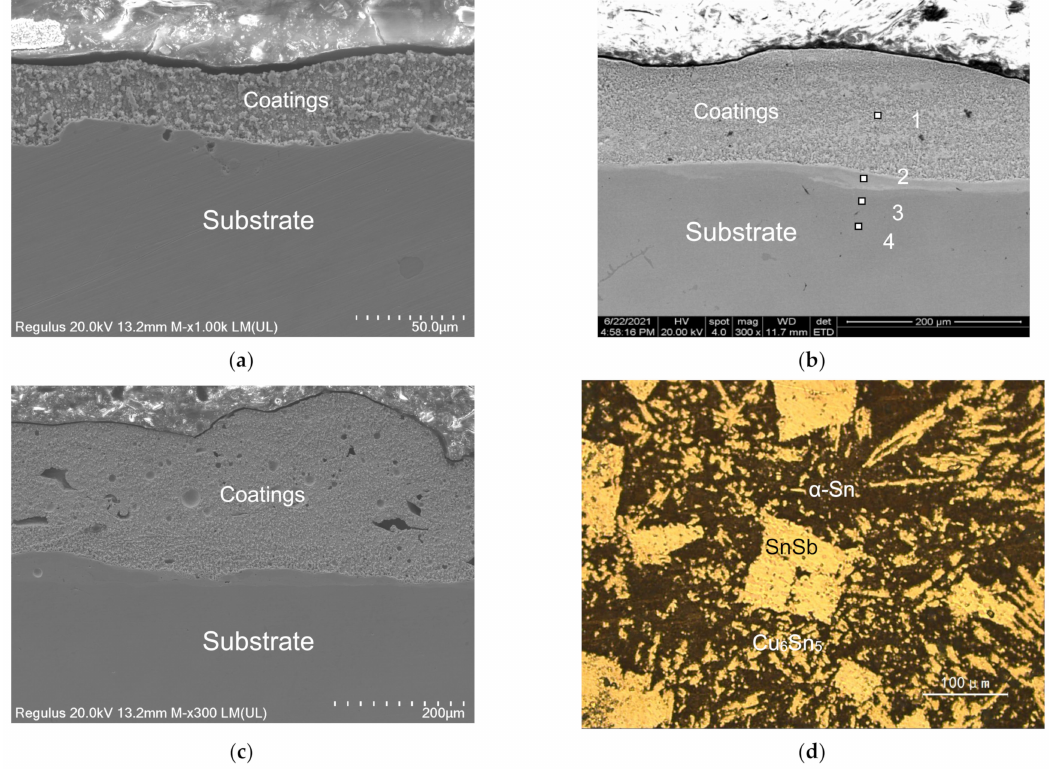
Figure 4. The cross-section morphology: ( a ) the running-in coatings of specimen 1; ( b ) the running-in coatings of specimen 2, 1—research area 1, 2—research area 2, 3—research area 3, 4—research area 4; ( c ) the running-in coatings of specimen 3; ( d ) Babbitt